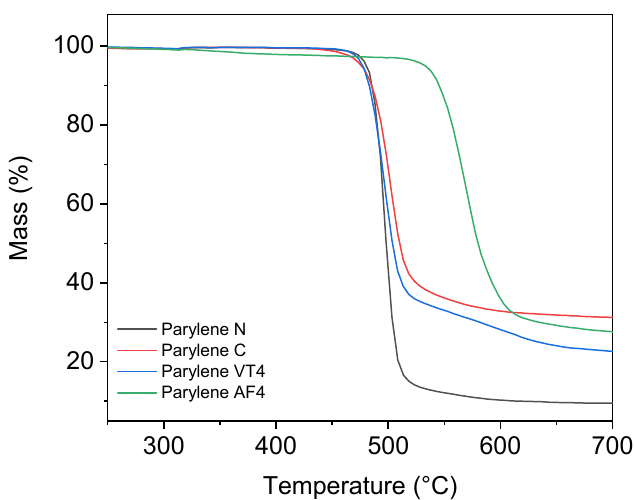
Figure 3. Thermogravimetric analysis results of parylene type N, C, VT4, and AF4.